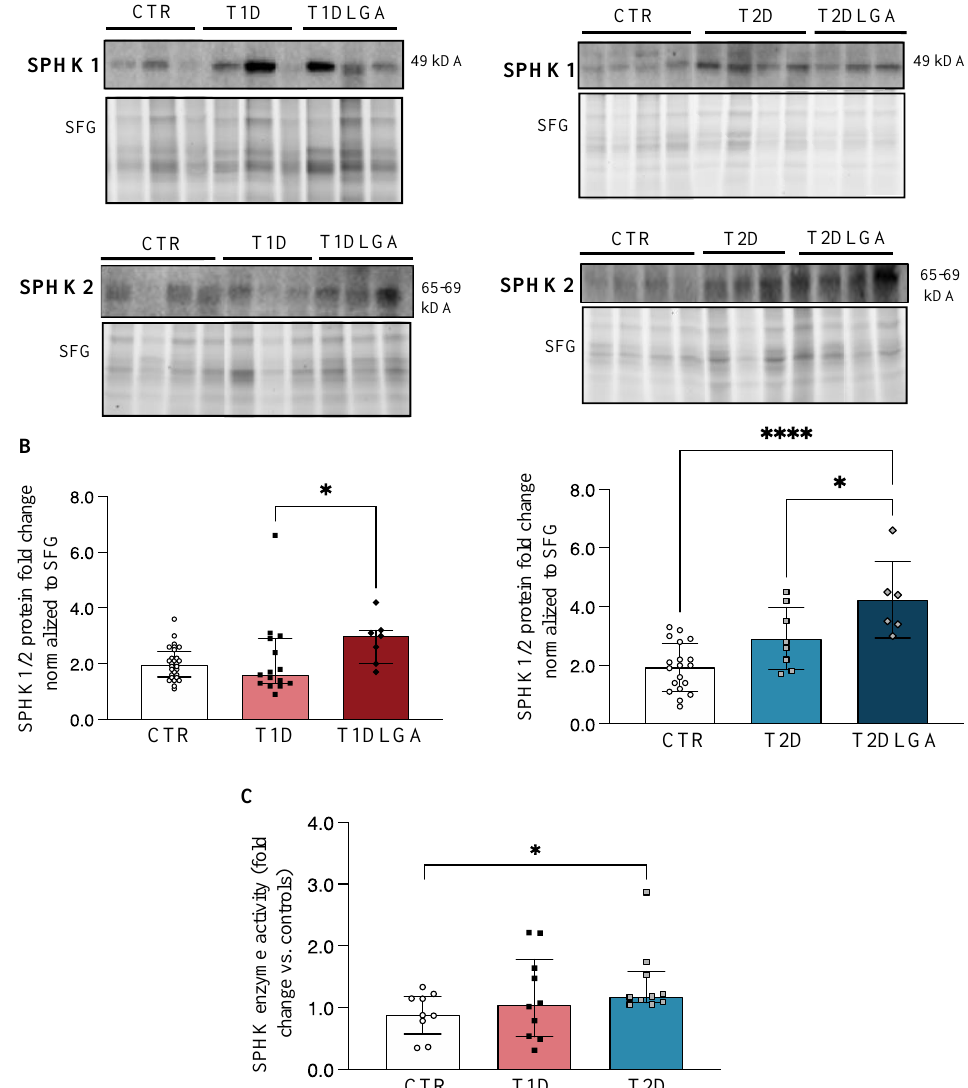
Figure 2. Sphingosine kinase (SPHK) levels and activity in diabetic placentae and in vitro conditions mimicking diabetes. (( A ), left panel) Representative Western blots for SPHK1 and SPHK2 in placental lysates from type 1 diabetes (T1D) with and without fetal macrosomia (LGA) vs. Controls (CTR). (( A ), right panel) Representative Western blots for SPHK1 and SPHK2 in placental lysates from type 2 diabetes (T2D) with and without fetal macrosomia (LGA) vs. Controls (CTR). (( B ), left panel). Densitometric analyses of total SPHK (SPHK1 + SPHK2) levels in CTR ( n = 28), T1D ( n = 15), and T1DLGA ( n = 7) placentae (data are median ± IQR), and in (( B ), right panel) CTR ( n = 19), T2D ( n = 8) and T2DLGA ( n = 6) placentae (data are mean ± SD). ( C ) SPHK activity in CTR, T1D, and T2D pregnancies (data are median ± IQR). * p < 0.05; **** p < 0.0001.